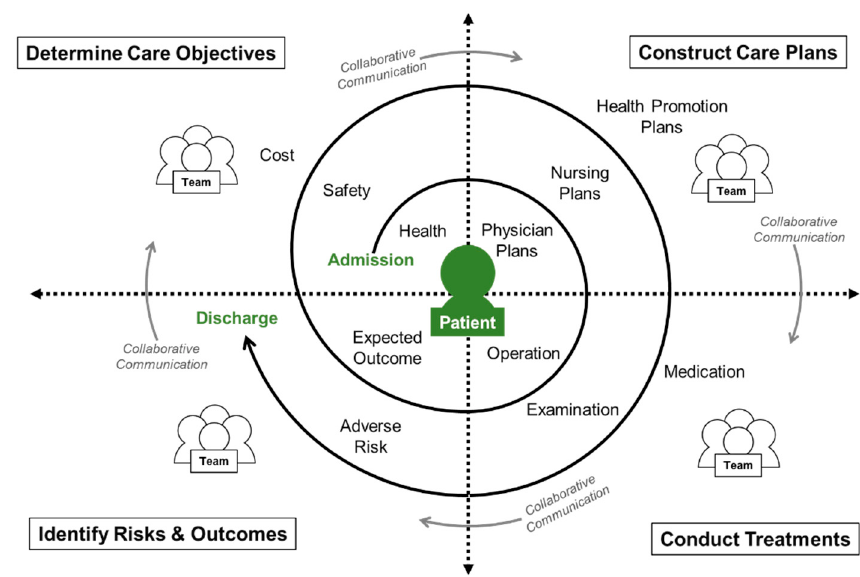
Figure 1. Interprofessional collaboration (IPC) spiral-shaped information flow for patient care.